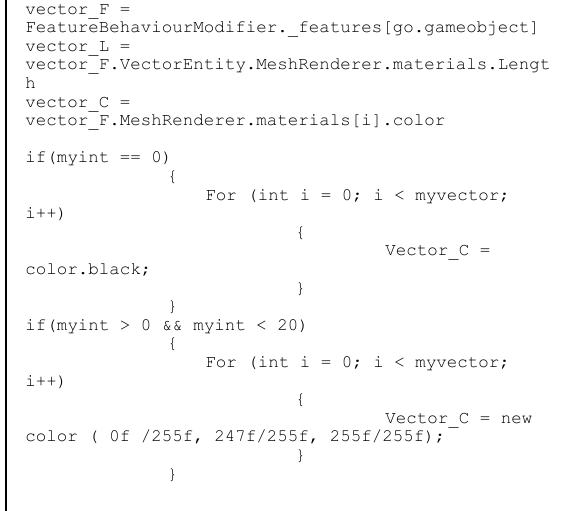
Figure 12. Fragmented script for pipeline colour rendering